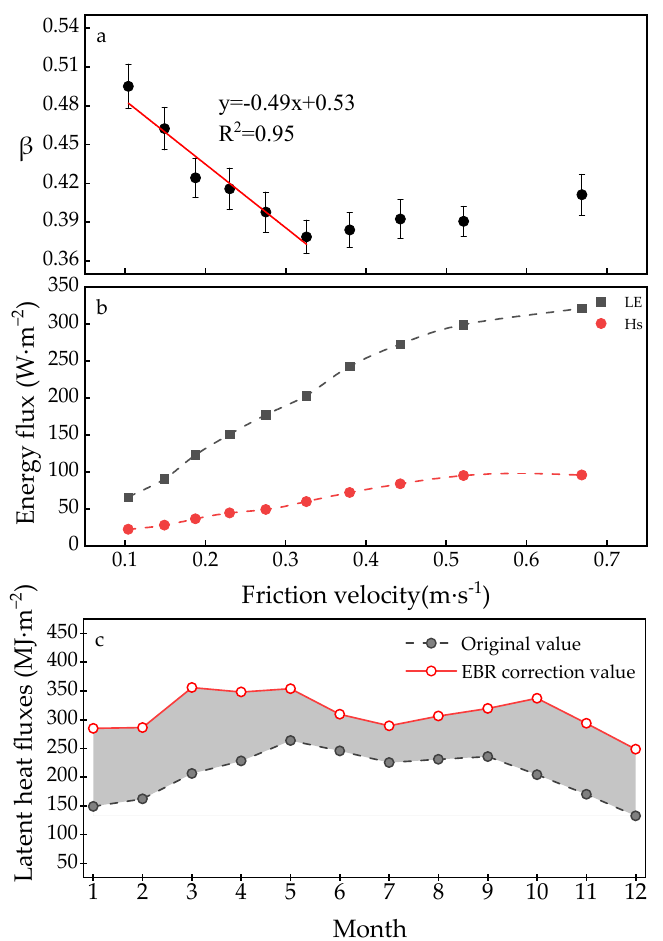
Figure 9. ( a ) Bowen ratio, β and ( b ) turbulent flux, LE and Hs as a function of u*, and ( c ) monthly variation of LE correction values. Where the straight line in ( a ) is the best-fit line of β at u* < 0.32 m · s − 1 , satisfying the equation β = − 0.49u* + 0.53, R 2 = 0.95, and ( c ) the shaded part is the underestimated part of